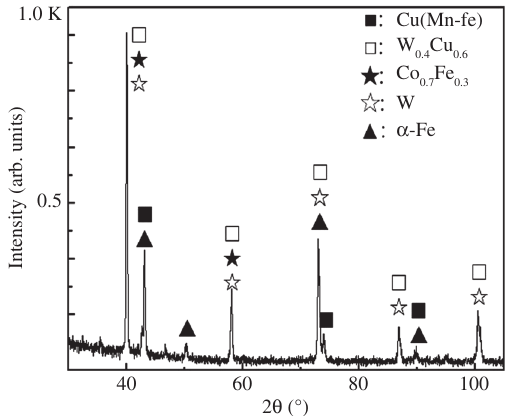
Figure 6 XRD analysis of brazed joint on the interface with Cu- based